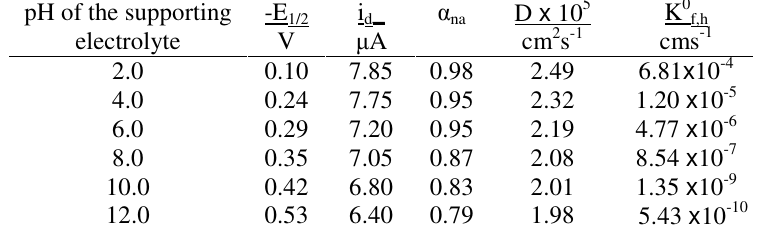
Table 1. Typical D.C. polarographic data of zileuton, Concentration: 0.5mM, Drop time: 2 sec.